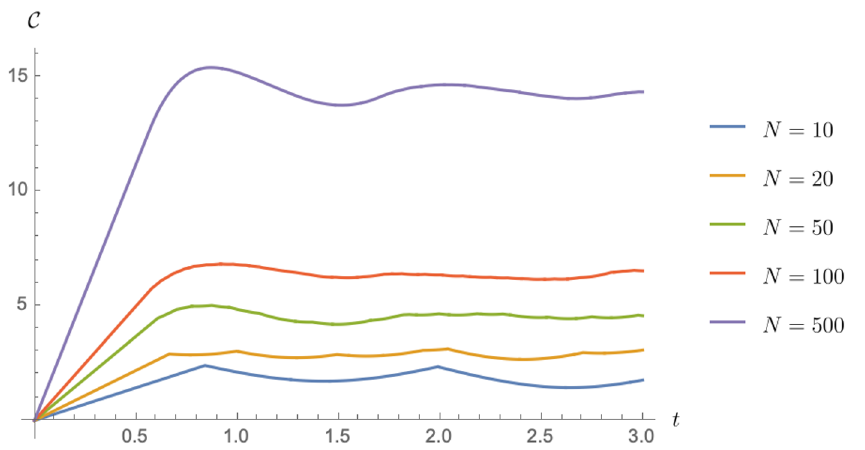
Figure 2 . A plot of complexity C ( t ) for instances of the N = 10 , N = 20 , N = 50 , N = 100 , and N = 500 free SYK model with J = 1 . The ω p / 2 which control the growth of the coefficients c p ( t ) in (3.33) are the positive eigenvalues of the antisymmetric coupling matrix J ij whose entries are independent Gaussian random variables with mean zero and variance σ 2 = J 2 /N